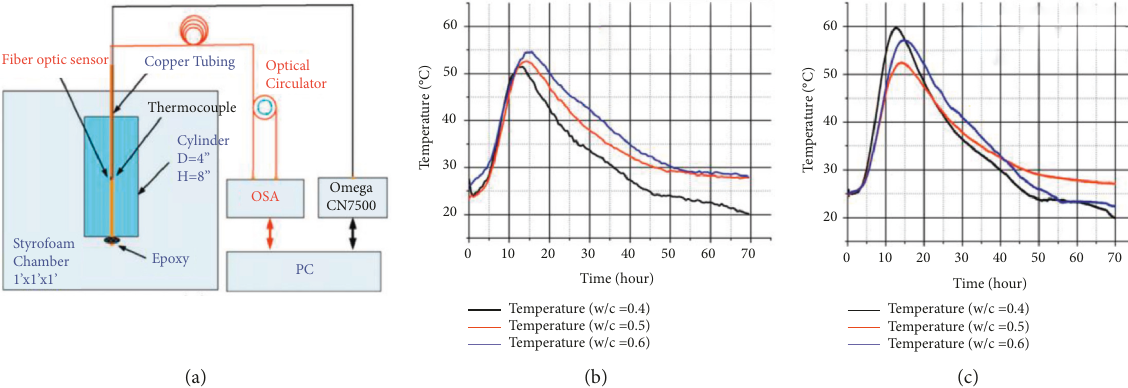
Figure 14: (a) Concrete hydration process concrete internal heat monitoring [78]. Early temperature variations in hydration tests: (b) smart OFRC. (c) Plain concrete measured with thermocouple [78].